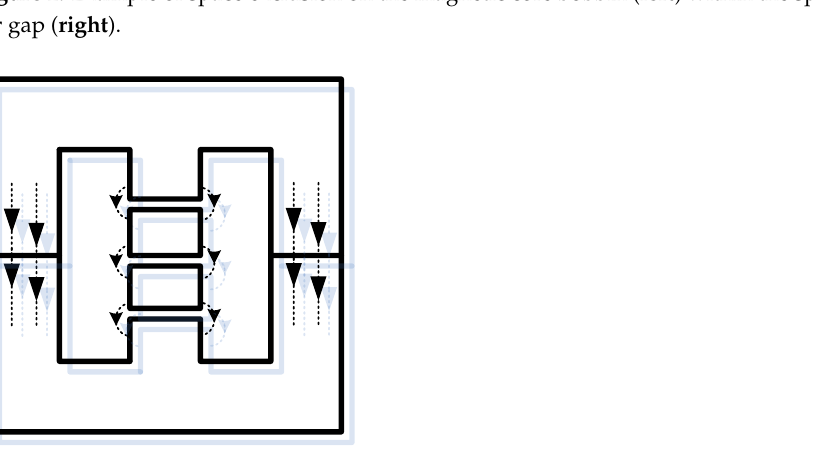
Figure 3. Example of the distributed air gap implementation within the E-shape core.